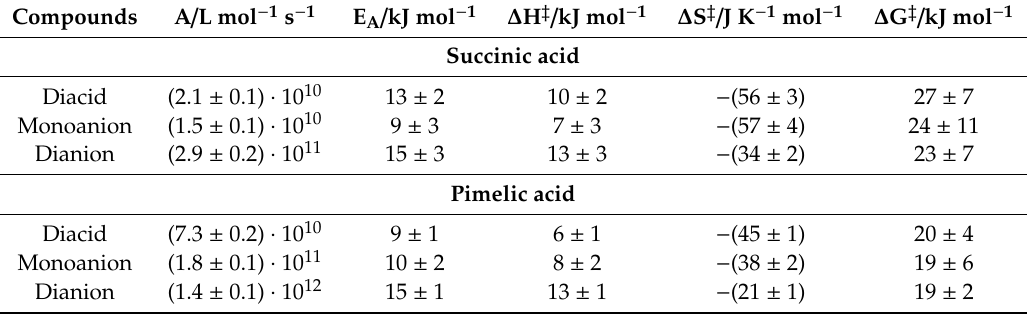
Activation parameters of the studied OH reactions in aqueous solution. Arrhenius pre-exponential factor, A, and activation energy, E A , Gibbs free energy, ∆ G ‡ , enthalpy, ∆ H ‡ , and entropy, ∆ S ‡ , of